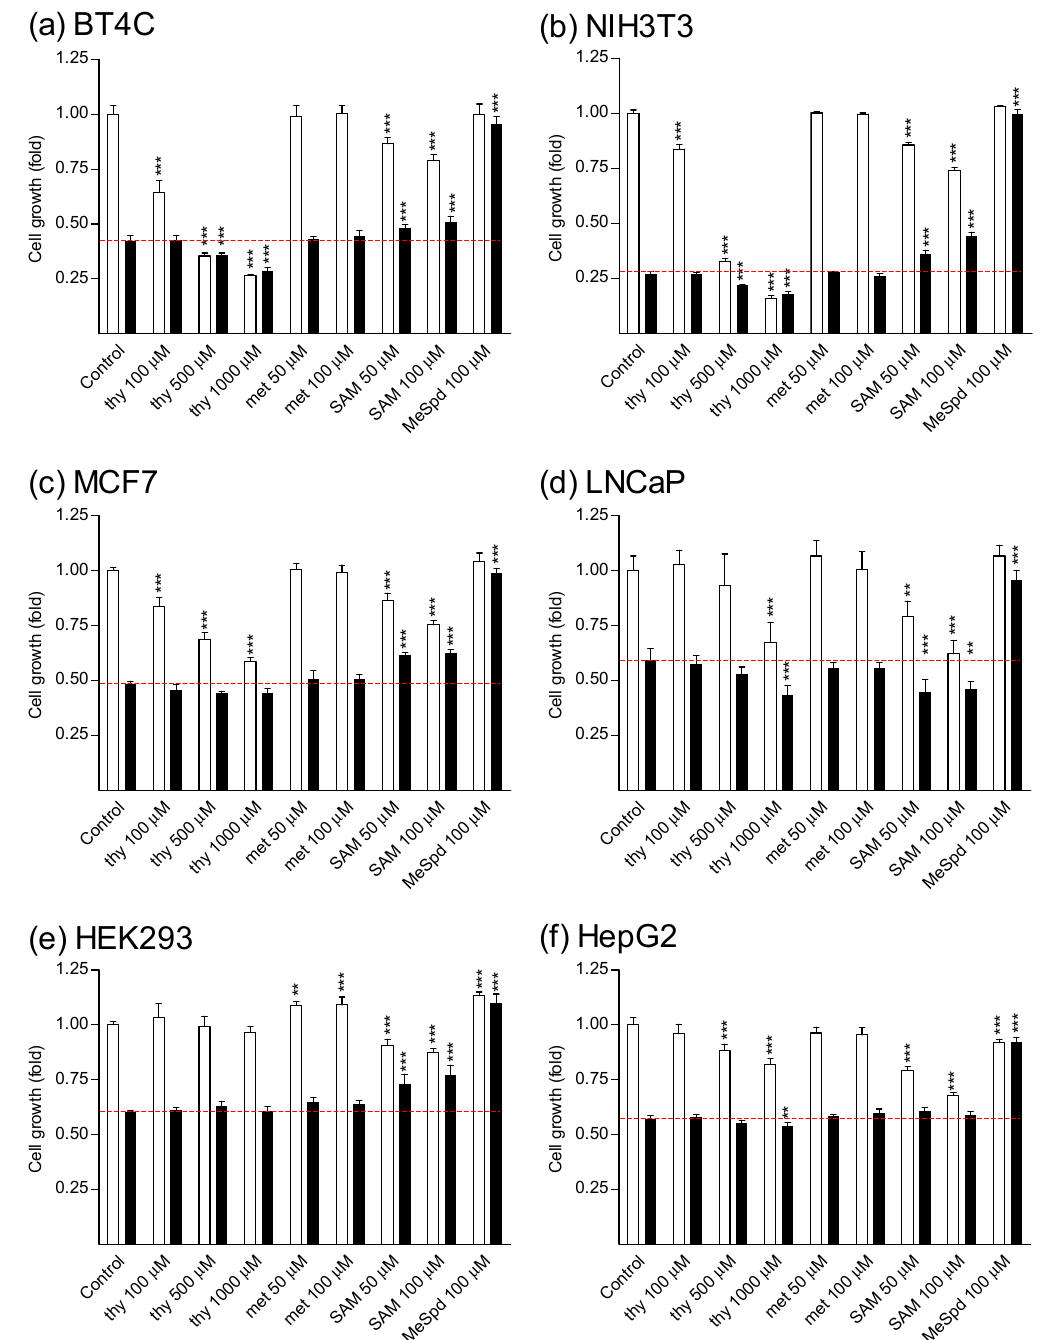
Figure 3. Effect of thymidine, L -methionine, SAM and ( S )-1-MeSpd on growth of various cell lines. ( a ) BT4C, ( b ) NIH3T3, ( c ) MCF7, ( d ) LNCaP, ( e ) HEK293, and ( f ) HepG2 cells. The cells were treated with thymidine (thy, 100–1000 µ M), L - methionine (met, 50–100 µ M), SAM (50–100 µ M) or ( S )-1-MeSpd (MeSpd, 100 µ M) in the presence (black bars) or absence (white bars) of 5 mM DFMO for 4 days. Data are means ± SD, n = 6. **, and *** refer to statistical significance of p < 0.01 and p < 0.001 as compared to control/DFMO groups, respectively. The red dotted line indicates the level of cell growth of DFMO-treated cells.